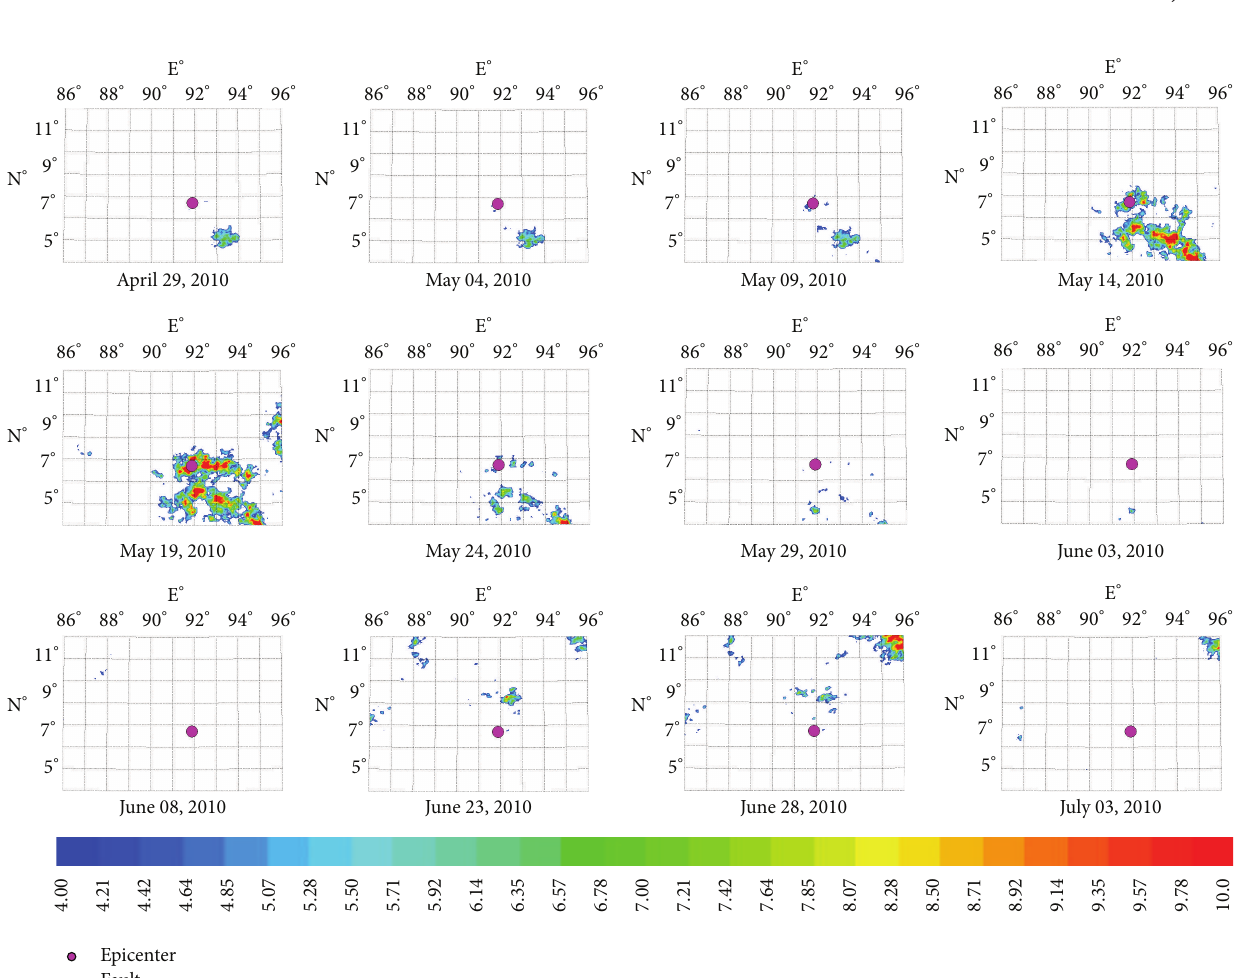
Figure 6: Space-time evolution of Nicobar Islands Ms 7.6